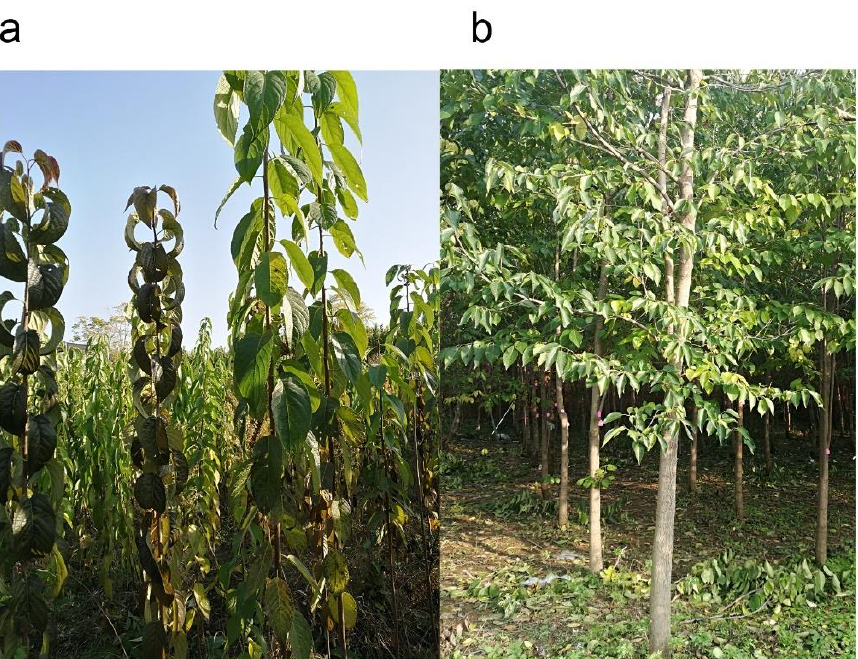
( b ) the Arbor forest